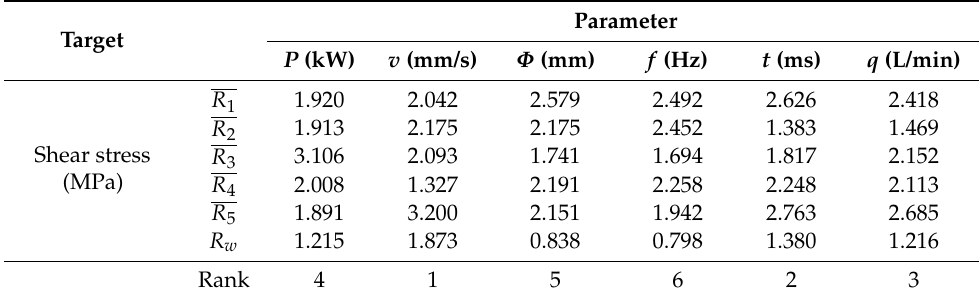
Table 5. Range analysis results of shear stress ( σ